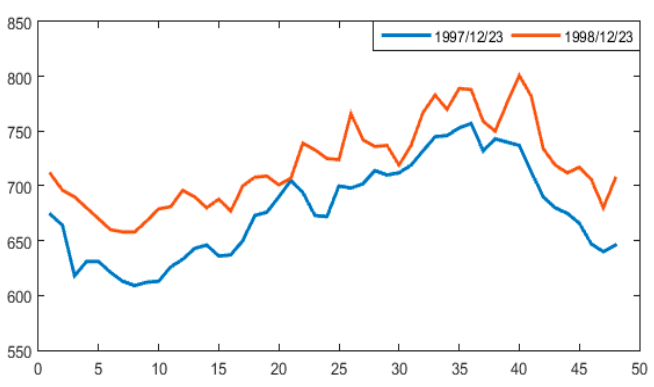
Figure 11. Typical load curves of clusters 10, 11, 12.